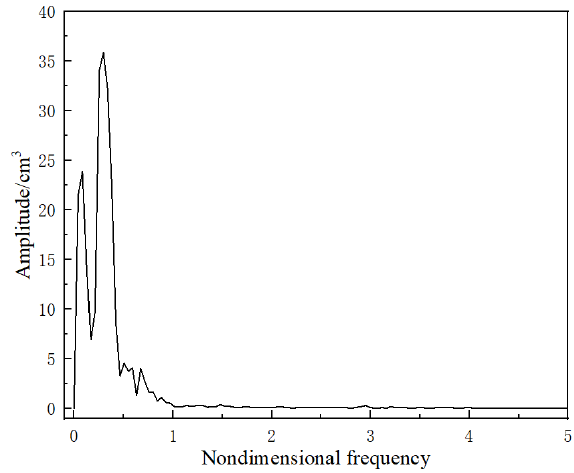
Figure 7. Time-history curve and frequency spectrum analysis of vapor volume in the runner under working condition A (23% P n ; part-load condition). Note: Nondimensional frequency represents the ratio of simulated frequency to rotating frequency.